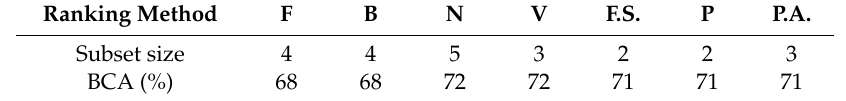
Table 8. Ranking methods performance comparison on the Spam dataset using Logistic